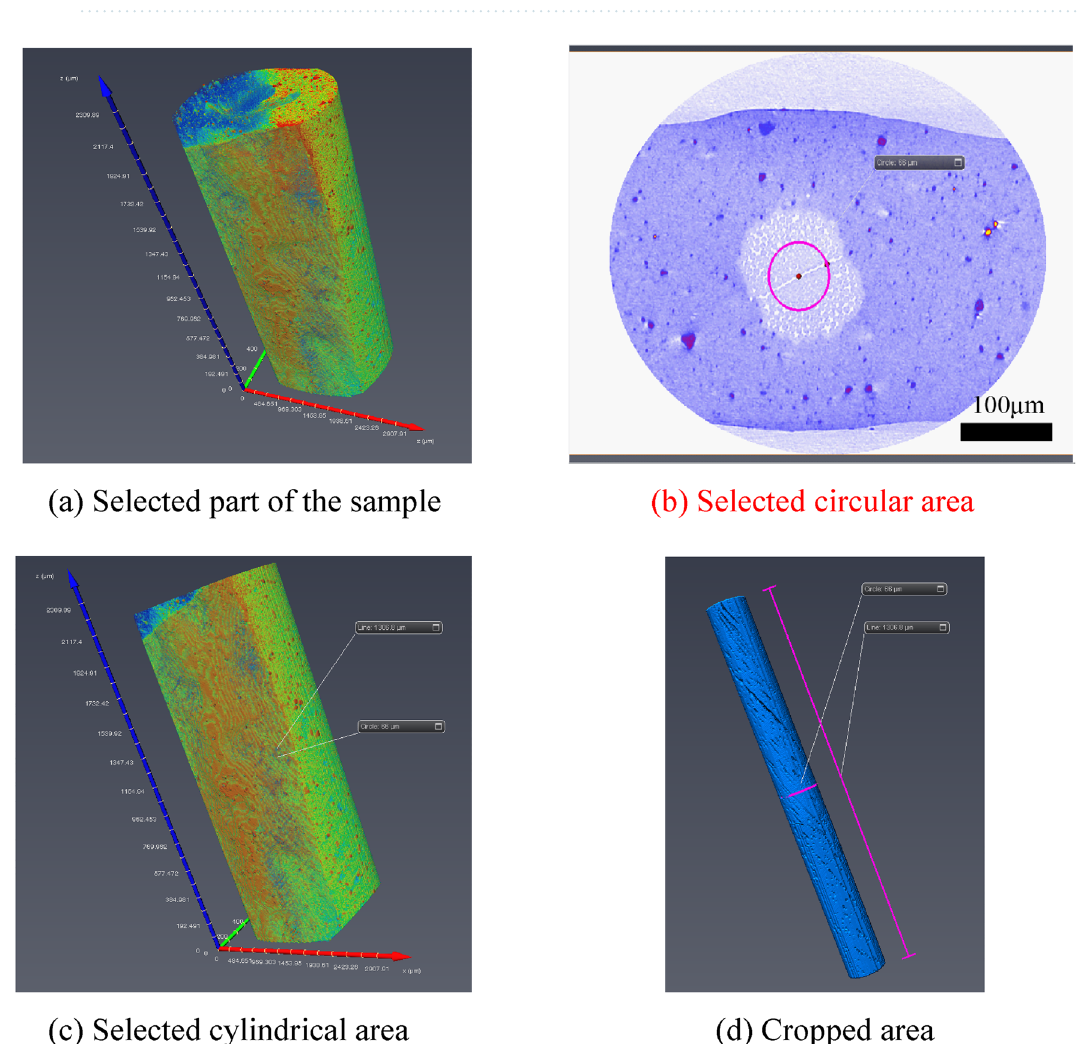
Figure 14. Area selection from the nylon-rubber CT